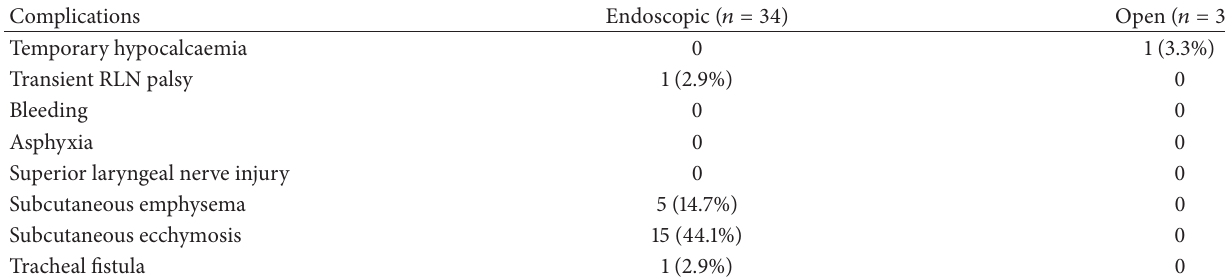
Table 2: Comparison of complications in endoscopic and open